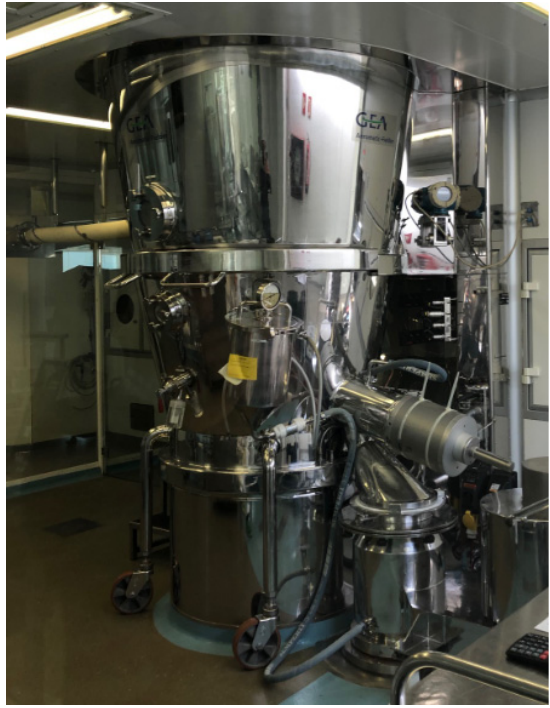
Figure 1. Fluid bed dryer model Fielder Aeromatic MP 6/8.